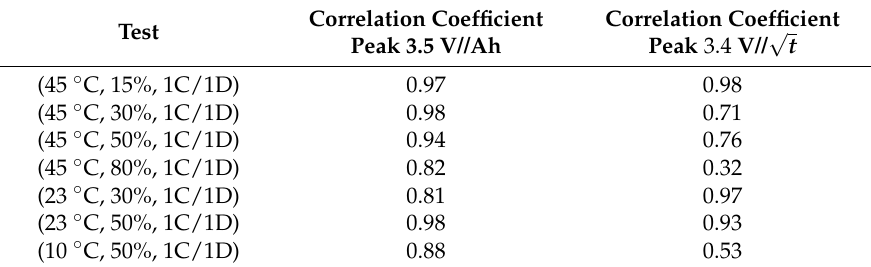
Table 5. Correlation coefficient of highest peak area with Ah and